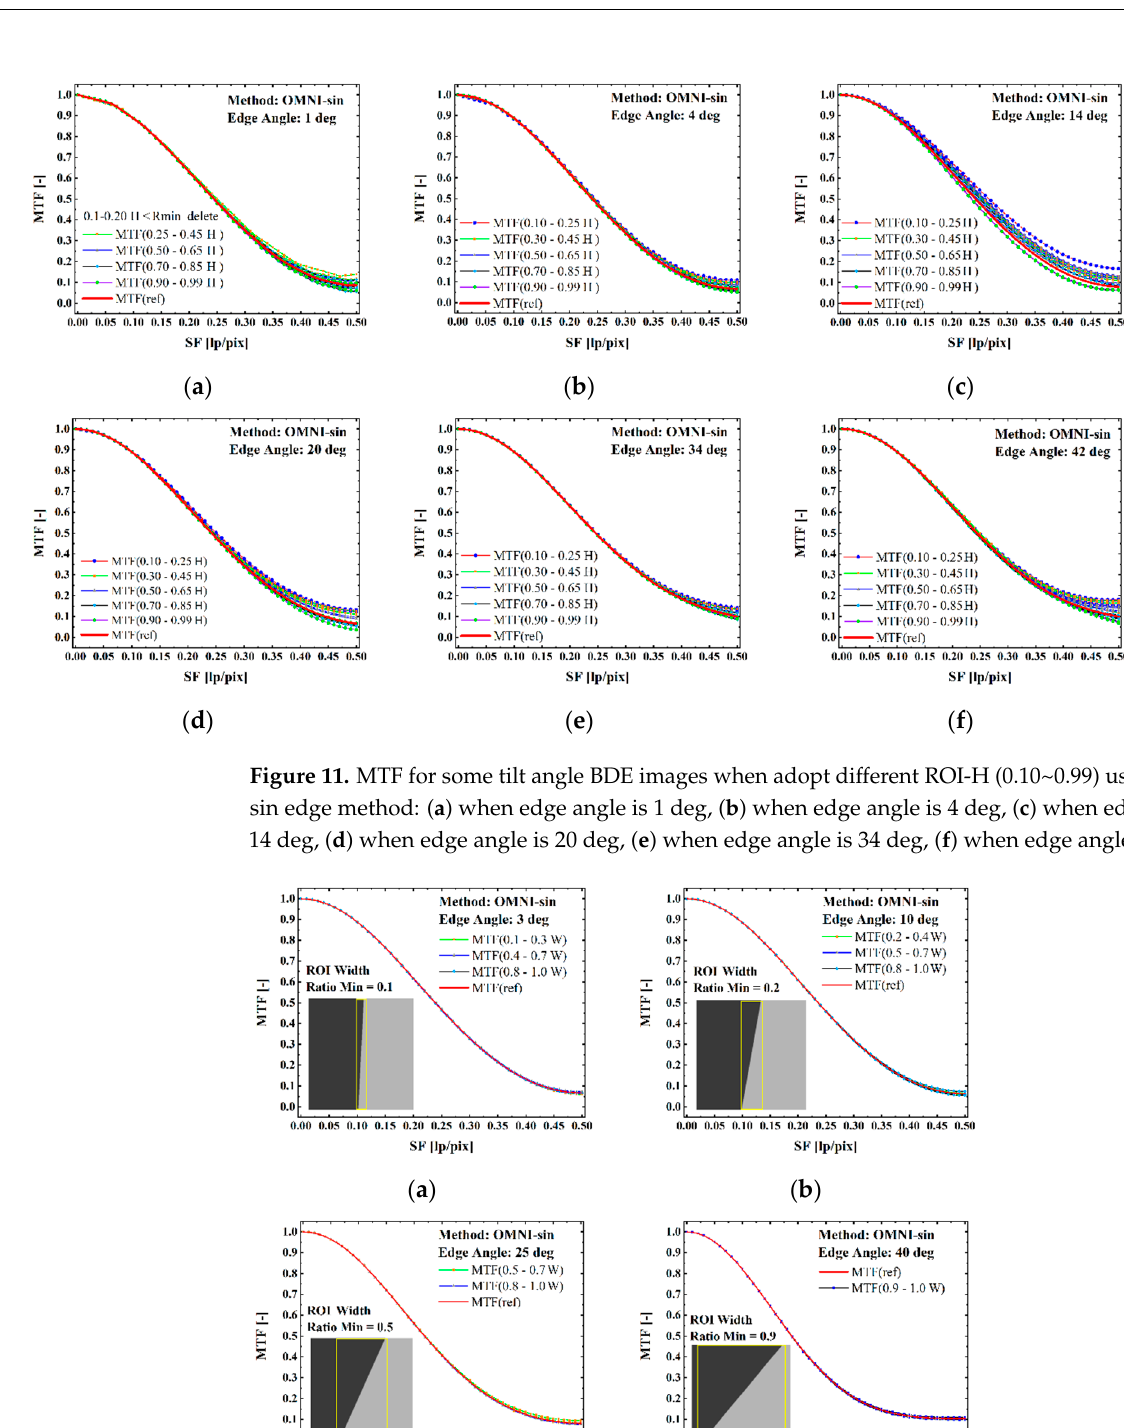
Figure 13. Graphic diagram of ROI extraction at minimum/maximum ROI-H and nor- mal/stretched/improper ROI-W: ( a ) when edge angle is 3 deg, ( b ) when edge angle is 10 deg, ( c ) when edge angle is 25 deg, ( d ) when edge angle is 40 deg. 3.4. Edge Contrast Generally, related studies have proved that contrast does not affect the accuracy of MTF measurement by edge method [10]. However, when the edge contrast is too low, that is, it is difficult to distinguish the edge visually, and the stability of MTF measurement results will also be affected. Therefore, in this section, contrast is analyzed again as an influencing factor. The BDE images with four angles of 3, 10, 25, and 40 deg, 400 × 400 pixels, and 300 dpi are determined for analysis, and the edge contrast is controlled at 0.04~0.84 by adjusting the gray values on both sides of the edge. The OMNI-sin edge method is used to measure the MTF of the edge images with different angles and different contrasts in Figure 3, and the simulation results are shown in Figure 14. Figure 14a–d show that the accuracy of the edge method is improved with the in- crease of edge contrast, but the improvement effect is not obvious. The consistency of MTF